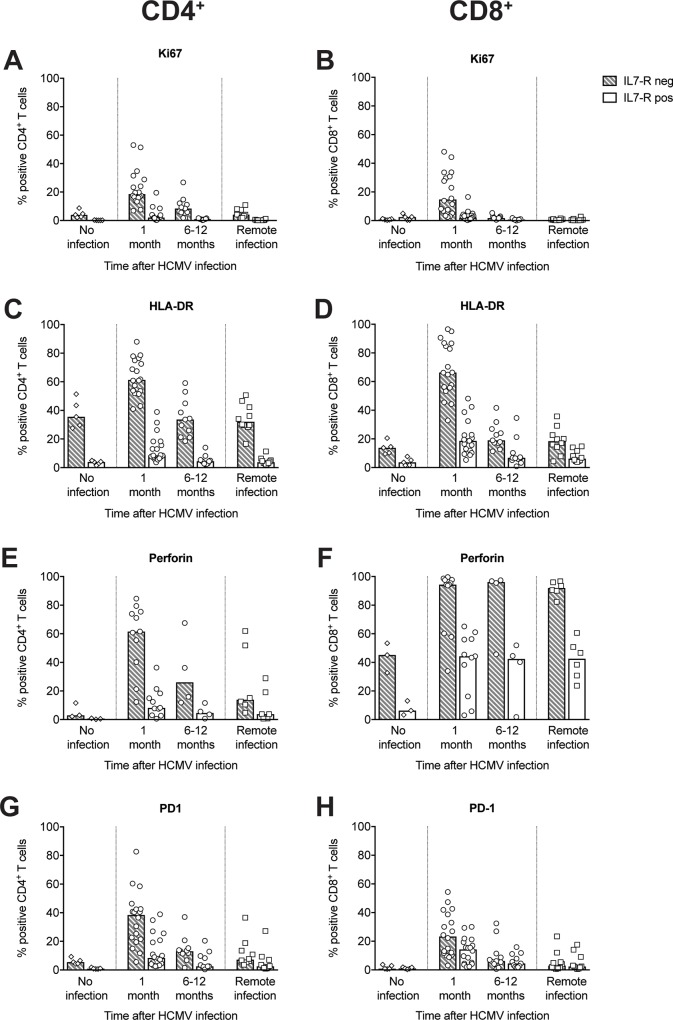
Characterization of IL-7Rneg and IL-7Rpos subsets among total memory T cells in subjects at different stages of HCMV infection.Data are reported for HCMV-seronegative subjects (“No infection”, n = 5), patients with primary HCMV infection 1 (n = 18) or 6–12 months (n = 11) after infection onset, or subjects with remote HCMV infection (n = 10). Percentages of CD4+ (left panels) and CD8+ (right panels) T cells in IL-7Rneg and IL-7Rpos subsets expressing (A,B) Ki67, (C,D) (HLA-DR, (E,F) perforin, and (G,H) PD-1 are shown. Each symbol represents an individual, and column upper limits indicate median values.